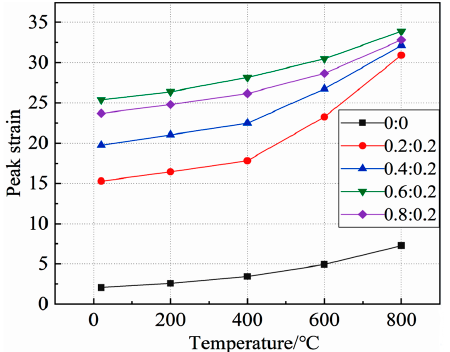
Figure 9. Relationship between concrete static pressure peak strain and temperature. As can be seen from the figure: